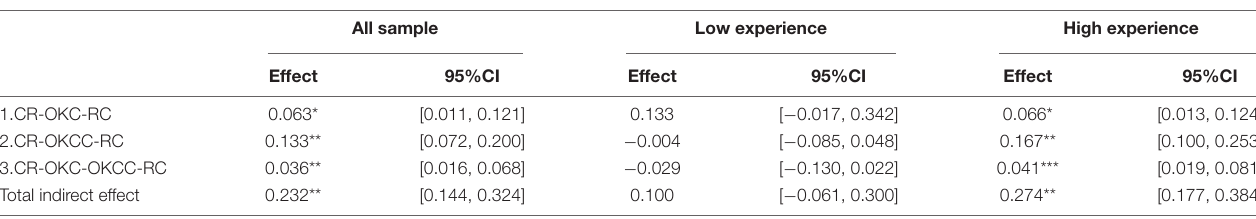
TABLE 3 | The indirect effect of character reading on comprehension via two mediators. All